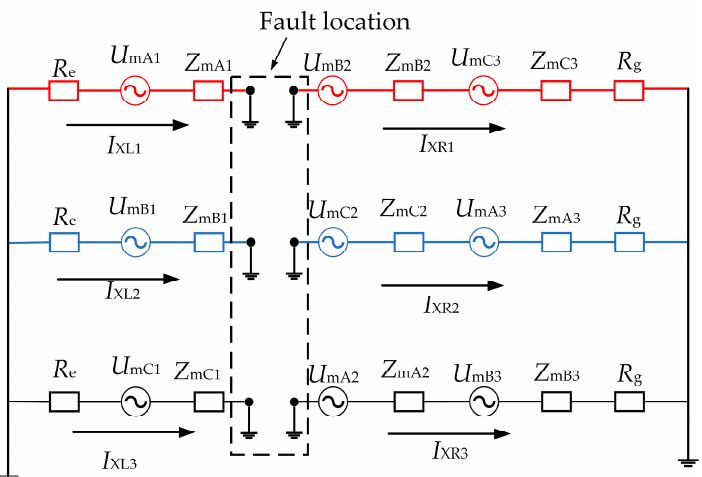
Figure 7. Equivalent circuit diagram of flooding in link box J1 fault.